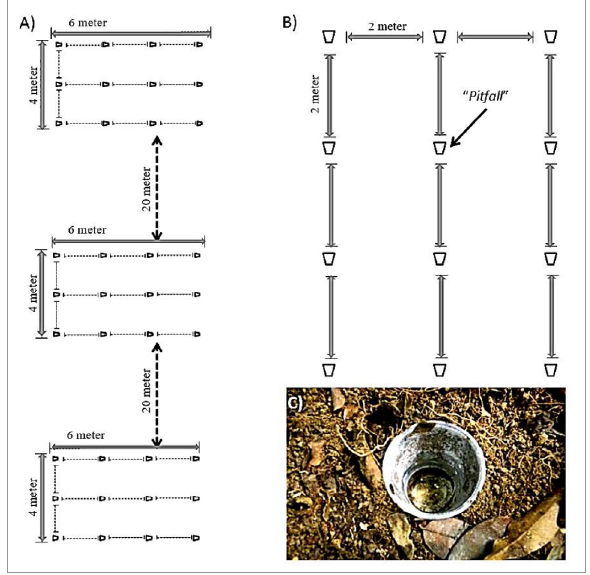
Figure 2: Method used to collect ants. (A) Distribution of sample plots in each location. (B) Distribution of pitfalls in each sample plot. (C) Photograph of a pitfall in the